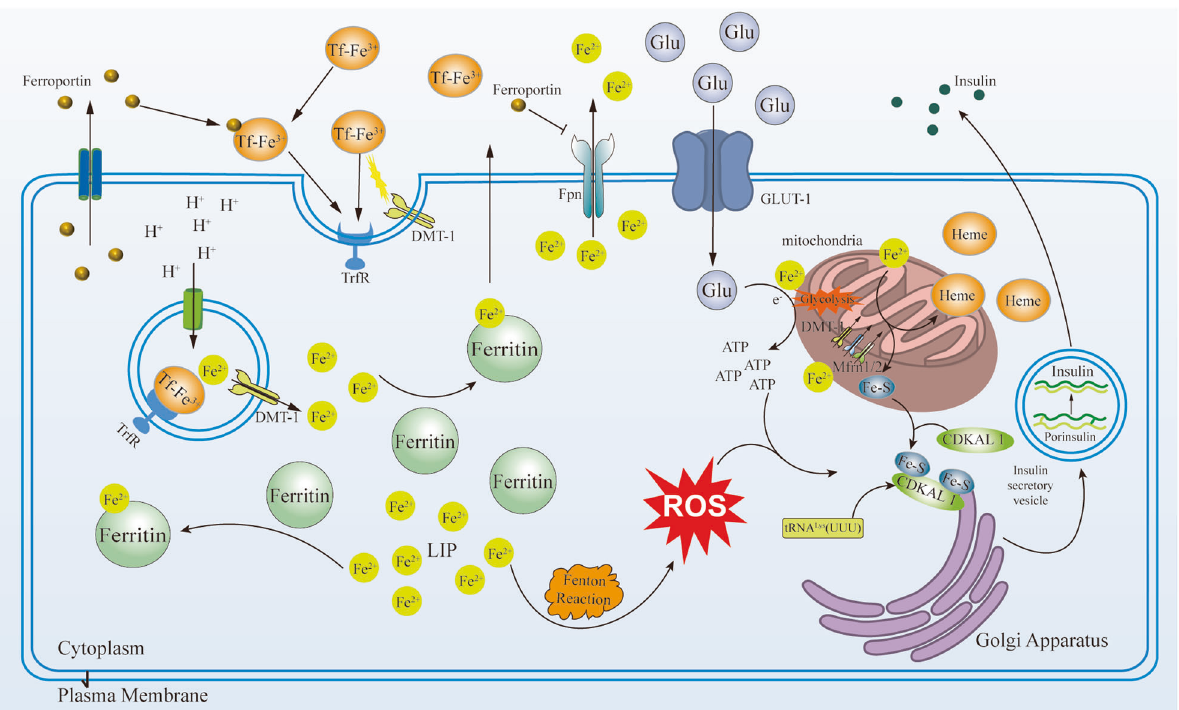
Fig. 2 Iron metabolism in pancreatic β cells. Iron metabolism in regulating insulin secretion in pancreatic β cells. Fe 3 + combined with transferrin (Tf) into Tf-Fe 2 + in the circulation. Tf-Fe 2 + binds to the transferrin receptor (TrfR) on the cell surface, and the receptor complex is endocytosed with the divergent metal transporter 1 (DMT-1). Inside the endosome, Fe 3 + is reduced to Fe 2 + and released into the labile iron pool (LIP). Ferritin combines with Fe 2 + in LIP to regulate the concentration of Fe 2 + in cells. In addition, Fe 2 + is discharged from cells through ferroportin (Fpn). The pancreas β cells, and hepatocyte can release hepcidin, which can induce Tf internalized and inhibit the activity of Fpn. Glucose (Glu) enters the pancreas β cells via glucose transporter 2 (GLUT-2) and performs glycolysis before entering the mitochondria, which leads to increased ATP production. Fe 2 + promotes the production of reactive oxygen species (ROS) through the Fenton reaction. Iron exchange in the mitochondria is mediated by DMT-1 and classical mitoferrins (Mfrn) 1 and 2, which can be incorporated into the electron transport chain and produce more ATP under the stimulation of glucose. Fe 2 + participates in Fe-S cluster biosynthesis in mitochondria. The Fe-S cluster promotes Cdkal1 catalytic metabolism of t 6 A37 in tRNA Lys UUU to ms 2 t 6 A37 and enables the normal processing of proinsulin into